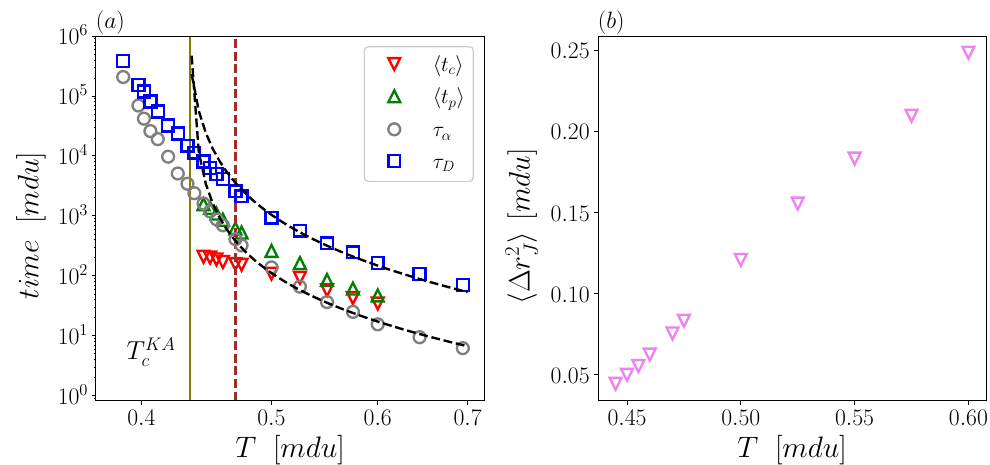
t p t c and ) timescales as a function of (cid:104) (cid:105) (cid:104) (cid:105) T KA c ) − γ with T KA c = 0.435, γ = 2.2 for τ α and −